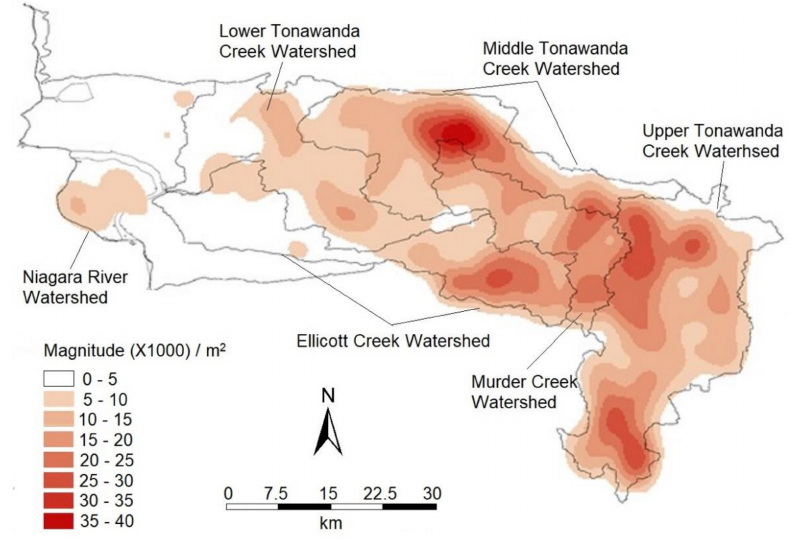
Figure 5. Kernel density analysis illustrating the density (magnitude) of polygons corresponding to forested large wood (LW) recruitment zones in the Niagara